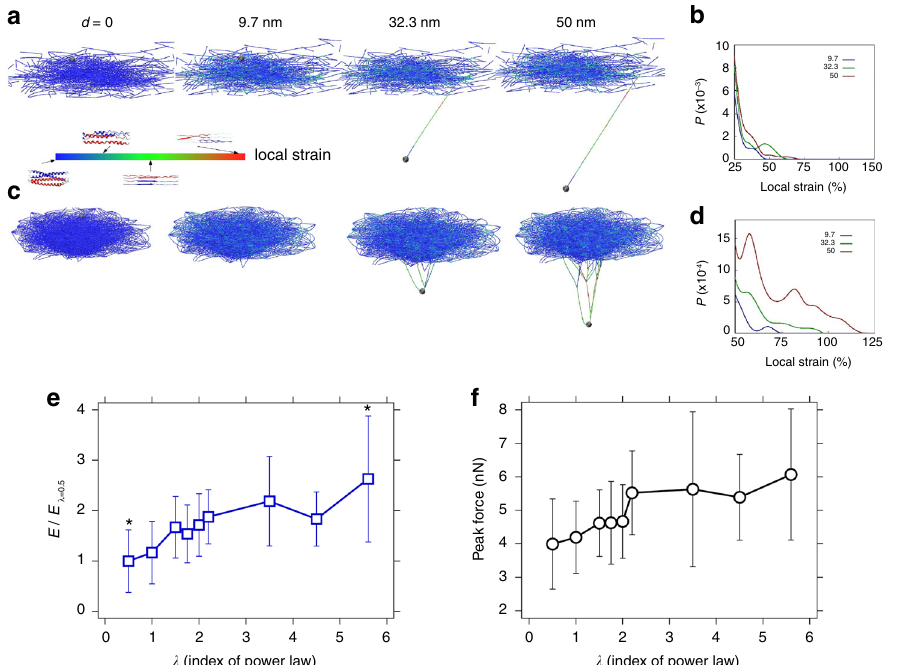
Fig. 6 Meshwork topology ( λ ) in fl uences toughness and strength of lamin fi laments. Snapshots from simulations of mechanical pushing of single lamin fi laments in meshworks of two different node connectivities: a λ = 0.5 (Supplementary Movie 1) and c λ = 5.6 (Supplementary Movie 2). The meshwork of λ = 0.5 was composed of many single fi laments connected to a few heavy nodes, while the meshwork of λ = 5.6 was composed of well-connected fi laments with a balance of light nodes, intermediate nodes and a few heavy nodes. The color scale denotes the local strain at different deformations, d , of the fi lament. b , d Probability distributions of the local strain within each fi lament segment measured at increasing deformations (corresponding to snapshots in panels a , c ) for the two meshworks. At λ = 0.5, the fi lament being pushed ruptured from one end at an early stage ( d < 32.3 nm), the other end was stretched and unraveled until the heavy node and the strain in the fi lament increased to cause rupture. At λ = 5.6, increasing deformation caused a large strain re-distribution. The meshwork with λ = 5.6 was associated with a much larger cohesive zone that enabled to dissipate more deformation energy before rupture (see “ Methods ” ). Lamin fi laments in meshworks with higher λ values were signi fi cantly e tougher ( E ) and f stronger as compared to fi laments in meshworks with smaller λ . Comparing the values from λ = 0.5 and λ = 5.6 with a t -test yielded a p value of 0.05 denoted by *. Each mean value and standard deviation in e and f are obtained from FE curves of 100 independent simulations on networks of the same λ value, as summarized in Supplementary Fig.